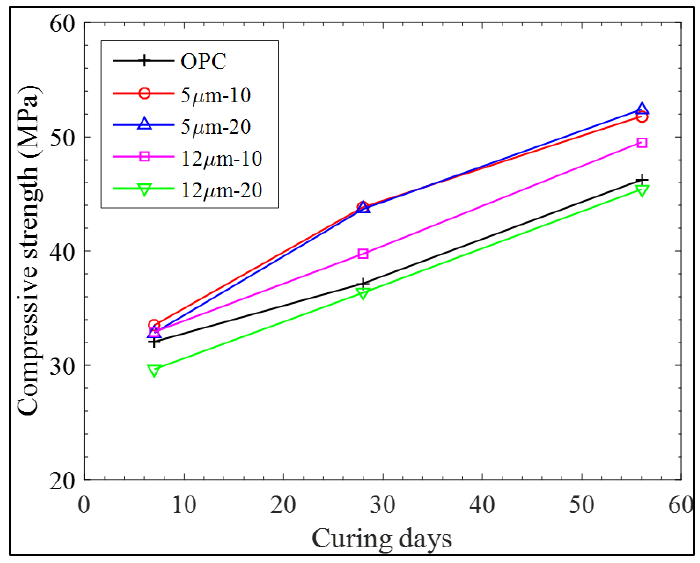
Figure 4. Compressive strength for LCD mortar at 7, 28, and 56 days.